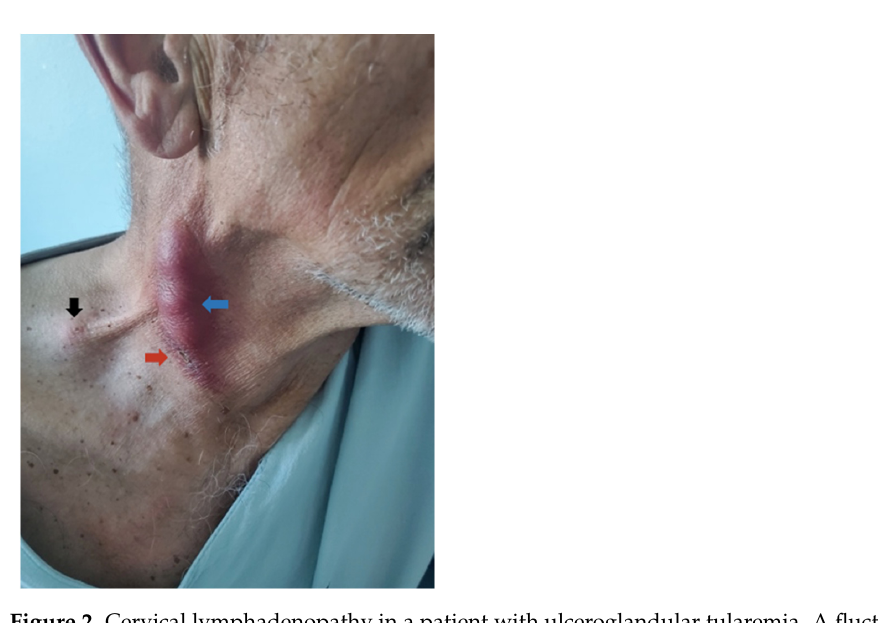
Figure 2. Cervical lymphadenopathy in a patient with ulceroglandular tularemia. A fluctuating neck mass is seen over the right sternocleidomastoid muscle (blue arrow), a superficial scab near the neck mass—a possible tick bite location and bacteria entry site (red arrow)—and enlarged supraclavicular lymph nodes on the right side (black arrow). Blue and red arrows anatomically correspond to Figure 1A–C and a black arrow to Figure 1D.